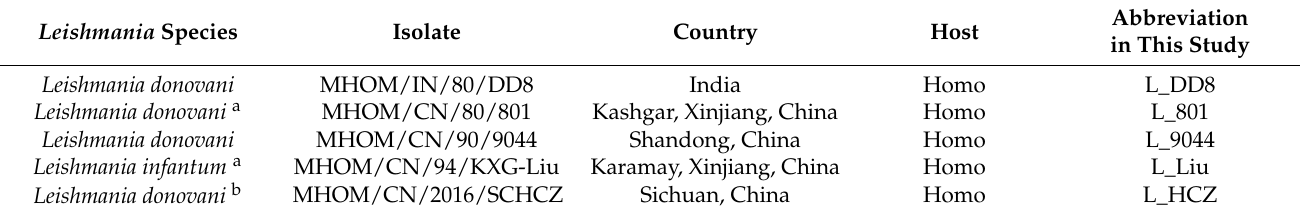
Table 1. Information of the five Leishmania clinical isolates in this